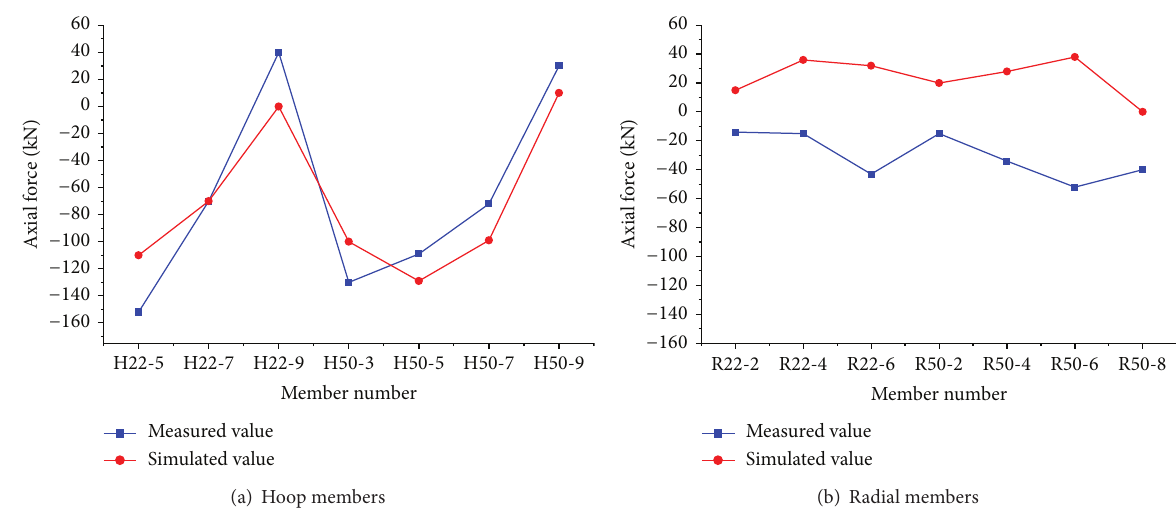
Figure 21: Pressure increment of strut.